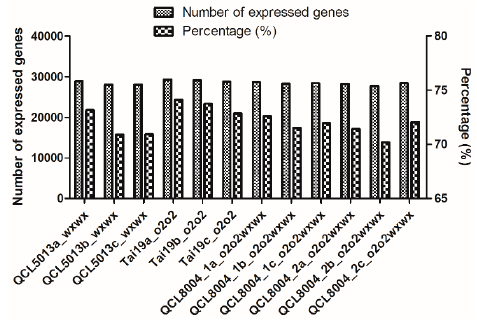
Figure 3. The number and percentage of identified genes in each sample.